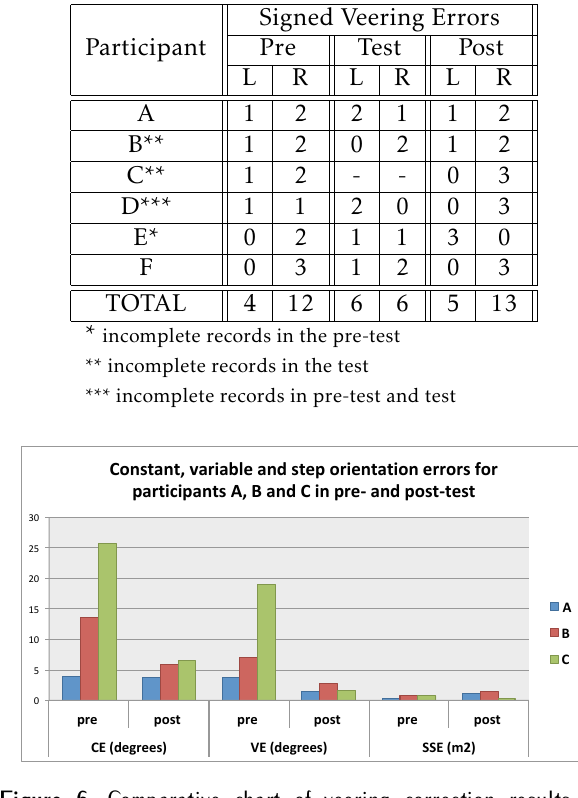
Figure 6. Comparative chart of veering correction results for participant A, B and